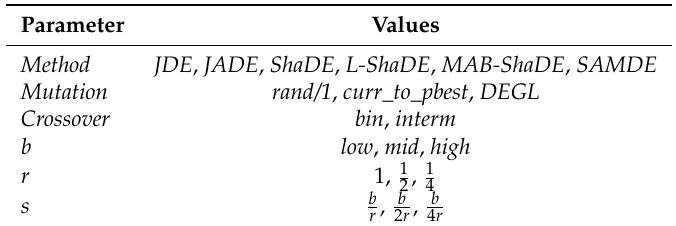
Table 1. Parameters values.